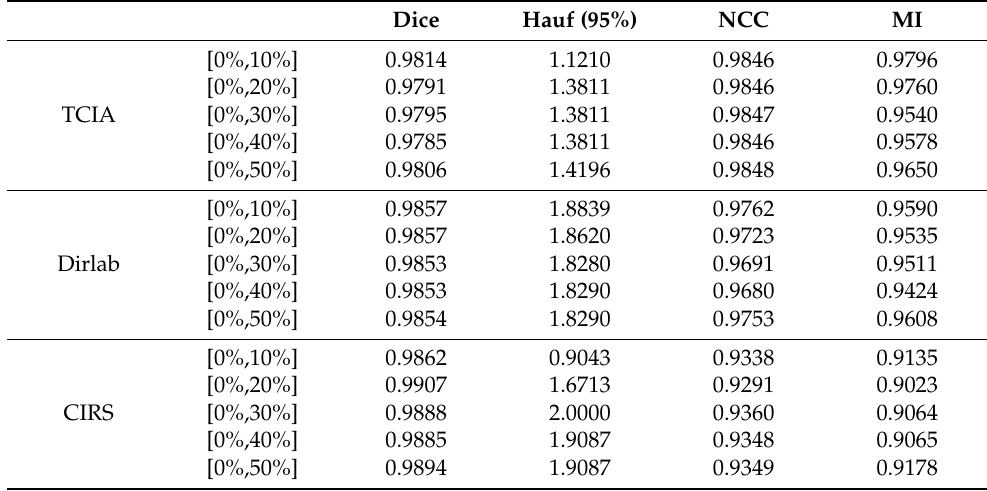
Figure 4. Registration from the exhalation end to the other stages. ( a ) shows the results of our registration on TCIA, ( b ) a randomly selected set of experiments from Dirlab, and ( c ) the registration results of the phantom data. The odd-numbered rows are the unregistered contrast images, and the even-numbered rows are the registered contrast images. Table 1. The accuracy of subjects’ registration from the expiratory end to each